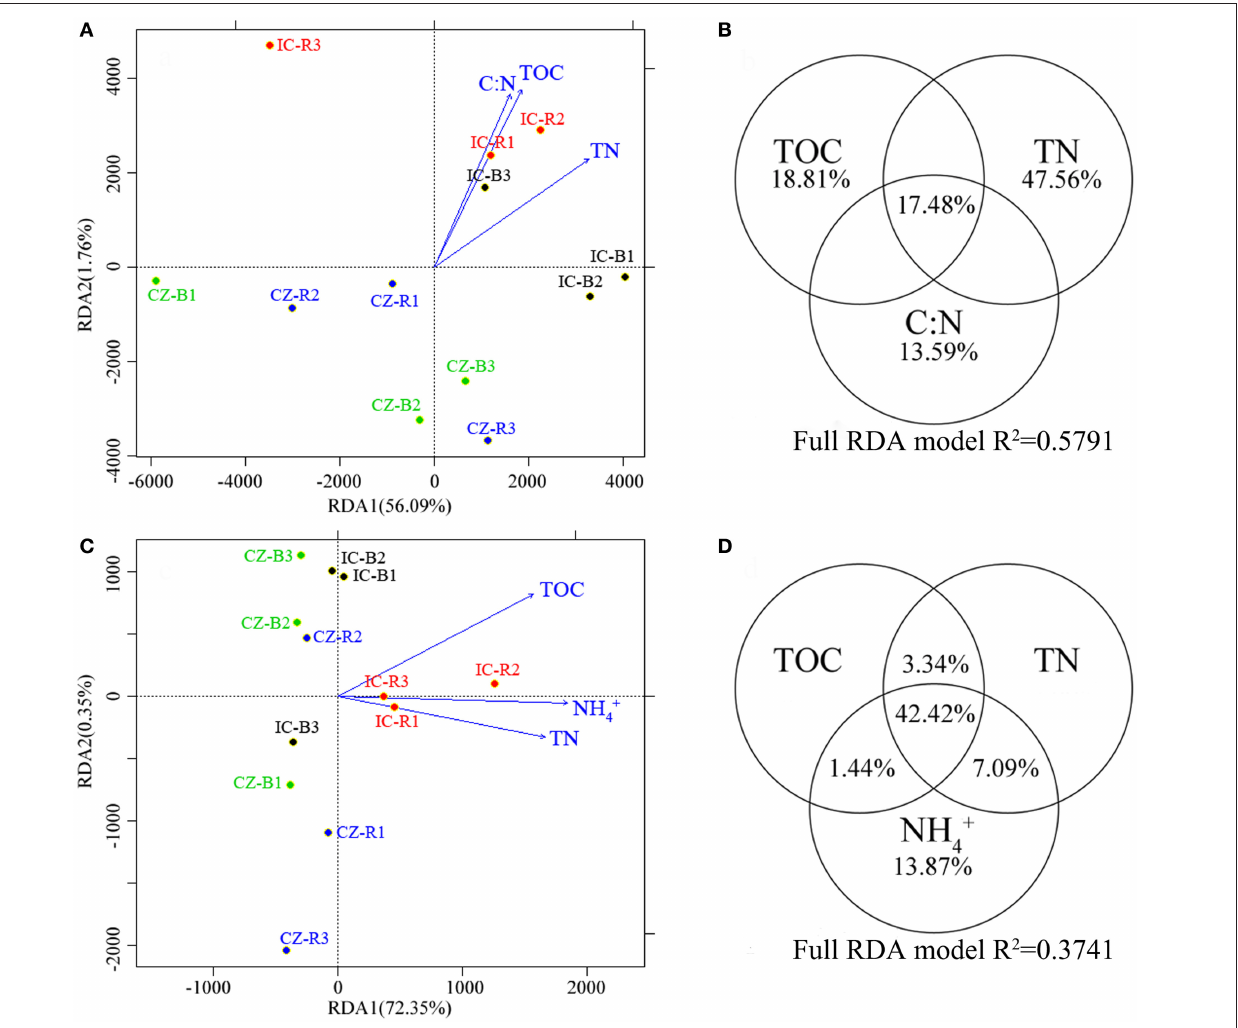
FIGURE 3 | A redundancy analysis (RDA) of the abundances (A) and transcript abundance (C) of microbial functional genes involved in the nitrogen cycle, and variance explained by the most important chemical properties in microbial functional gene abundance (B) and transcript abundance (D) . The circled values indicate the contributions of a chemical property to variations in microbial functional gene abundance or transcript abundance. Samples were bulk tailings of I. cylindrica (IC-B), rhizospheric samples of I. cylindrica (IC-R), bulk tailings of C. zizanioides (CZ-B), and rhizospheric samples of C. zizanioides